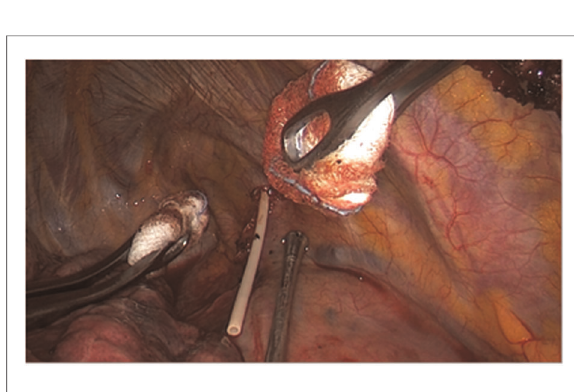
FIGURE 4 Surgical removal of the Port-a-Cath by triportal VATS: the central venous catheter of the Port-a-Cath is slowly removed, without bleeding, under safe guidance of the thoracoscopic